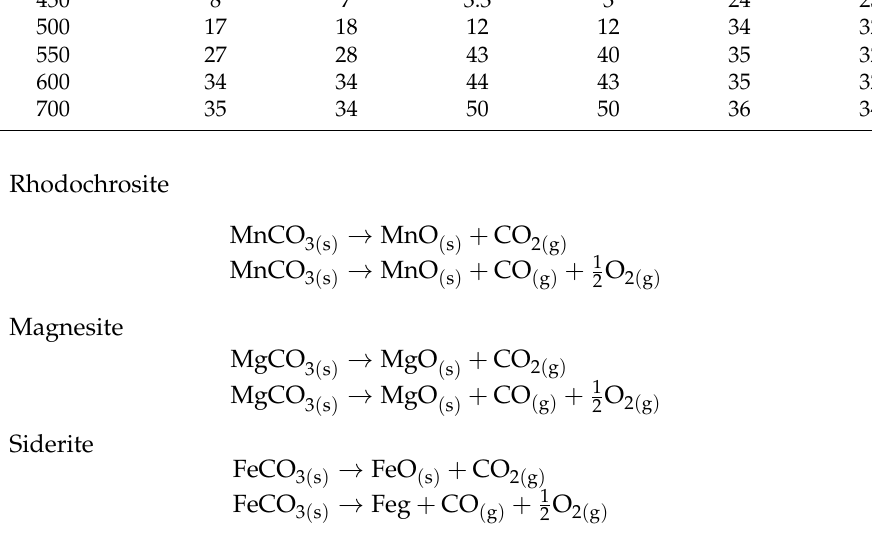
Table 4. Measured weight loss and weight loss calculated from the total of CO 2 and CO emissions (wt%) for rhodochrosite, magnesite and siderite in N 2 carrier gas. Meas—measured; Calc—calculated. Temperature ( ◦